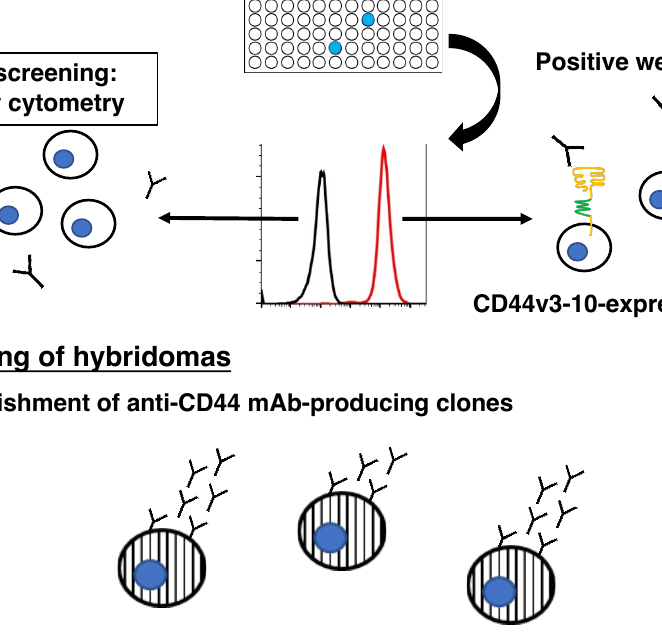
Figure 1. A schematic procedure of anti − human CD44 mAbs production. A BALB/c mouse was intraperitoneally immunized with the purified CD44v3 − 10 ectodomain. The screening was then conducted by ELISA using the purified CD44v3 − 10 ectodomain, flow cytometry using parental and CD44v3 − 10 − overexpressed CHO − K1